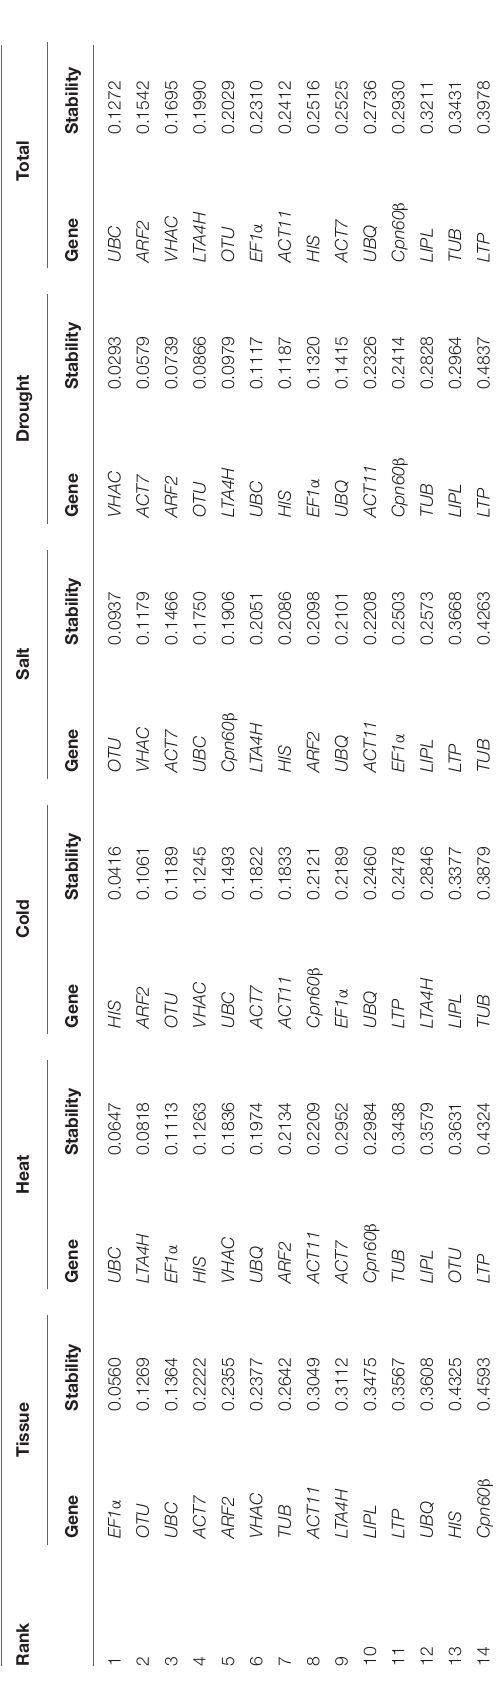
Figure S1A). For PCR specificity detection, the presence of a single peak in the melting curve was obtained after amplification (Supplementary Figure S1B).